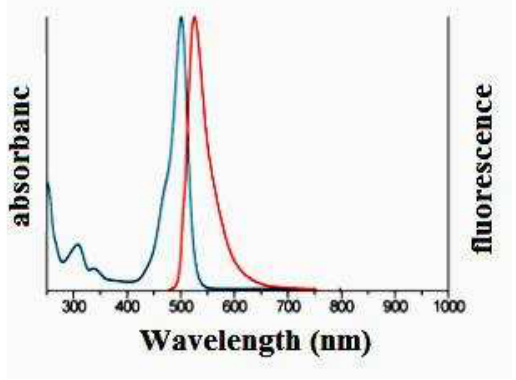
Figure 4. Fluorescence intensity of TNL-PE nanolipid vesicles (blue color wavelength); fluorescence intensity of TNL-PE-Ab nanolipid vesicles (red color wavelength). EDX data (Figure 5 and Table 1) show the weight % and atomic % of different ele- ments (C, O, and P) in the nanolipid vesicles. The weight percentages of C, O, and P in TNL-PE were 37.58, 51.45 and 10.97, respectively, and the values for TNL-PE-Ab was